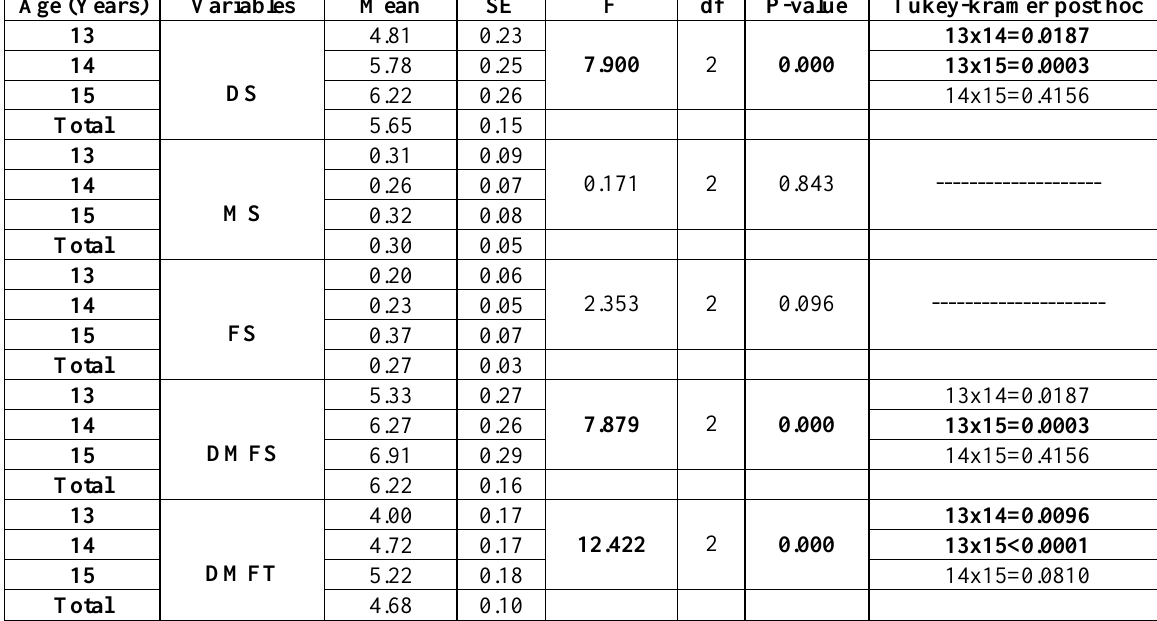
Table 7: Caries experience of the permanent teeth (mean and standard error) among students by age